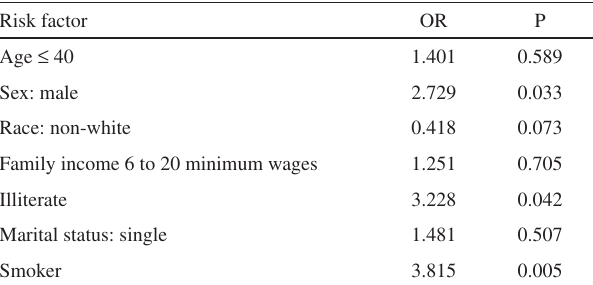
Table 3 - Results of logistic regression analyses for patients with a positive Alcohol Use Disorders Identification Test